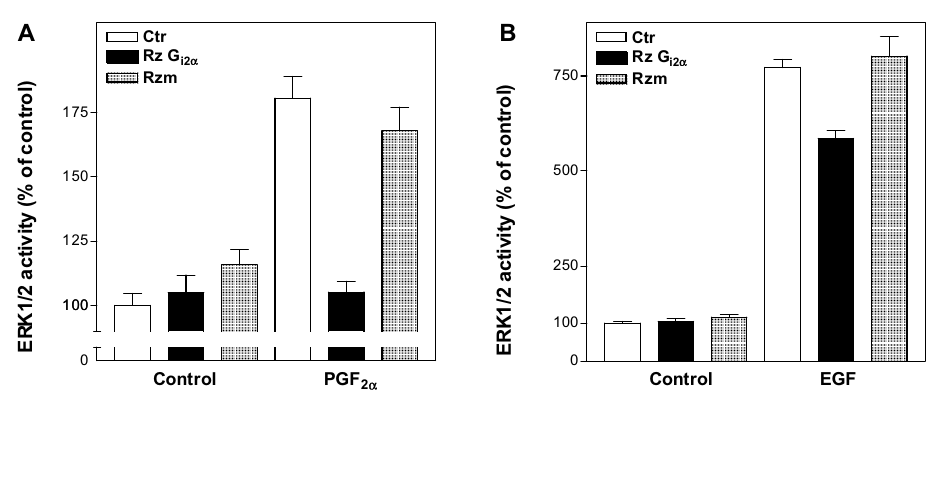
Figure 4 Effect of G i2 α ribozyme on ERK1/2 activation. G i2 α ribozyme (Rz) or non-cleaving G i2 α ribozyme (Rzm) complexed with DOTAP giving final ribozyme concentrations of 2.5 µ M, or DOTAP without ribozyme, were added to hepatocyte cultures at 4–5 hours after the time of seeding. After 30 h of treatment the cell cultures were stimulated with PGF 2 α (10 µ M) or EGF (10 nM) for 5 min before they were harvested and ERK1/2 activity assessed. Results are expressed as percent of untreated control and represent mean ± S.E.M. from three